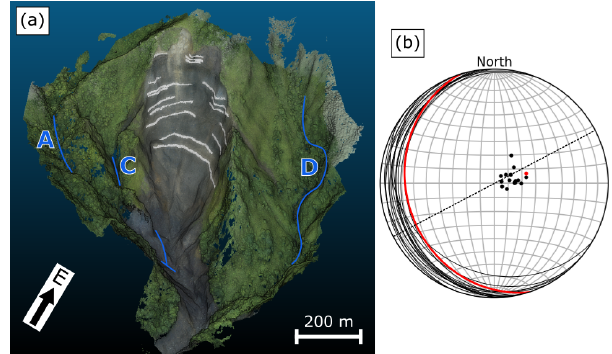
Figure 3. Deposition horizon orientation. (a) July 2010 photogrammetric 3D model, with deposition horizons (white lines). Ravines are highlighted by blue lines with their name, as in Fig. 1. (b) Wolff stereonet projection of deposition horizons (black lines), with corresponding poles (black dots). The contact S 0 between LPd and UPd is also given in red. The dashed black line gives the cliff retreat direction (azimuth 062 ◦ N, white line in Fig.